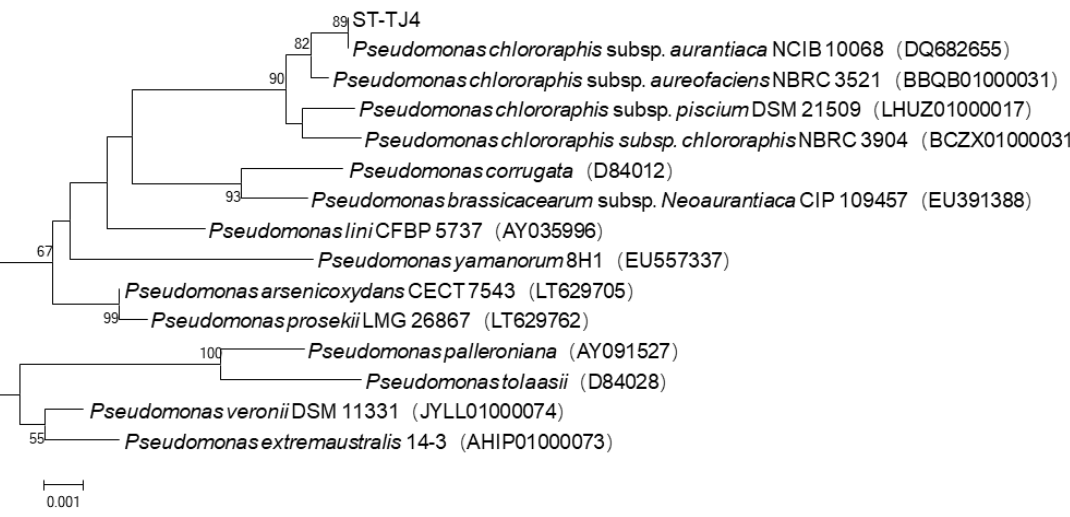
Figure 6. Morphological identification: colony morphology ( A ), oxygen demand test results ( B ), and Gram staining ( C ) of Pseudomonas sp. ST–TJ4.